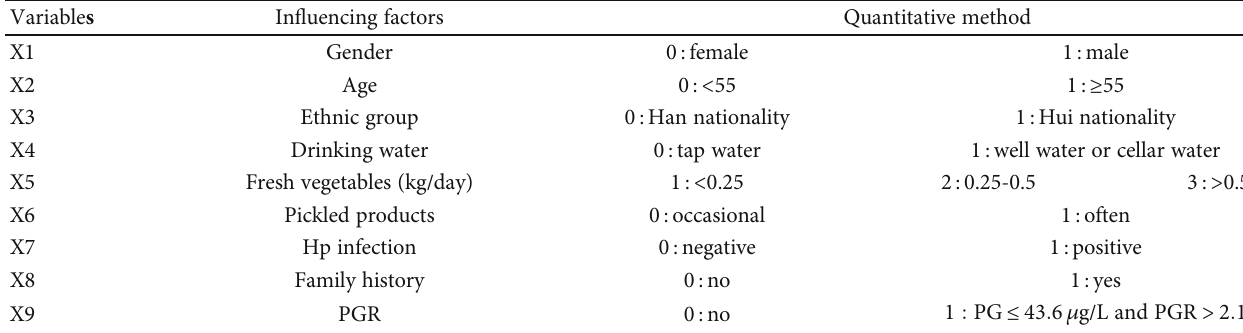
Table 2: Logistic regression model coding.